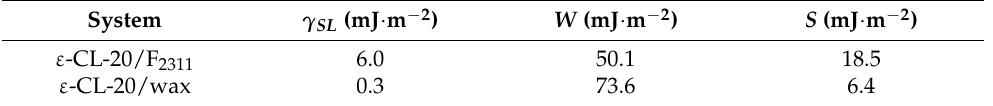
Table 3. Interface thermodynamic parameters of ε -CL-20/F 2311 and ε